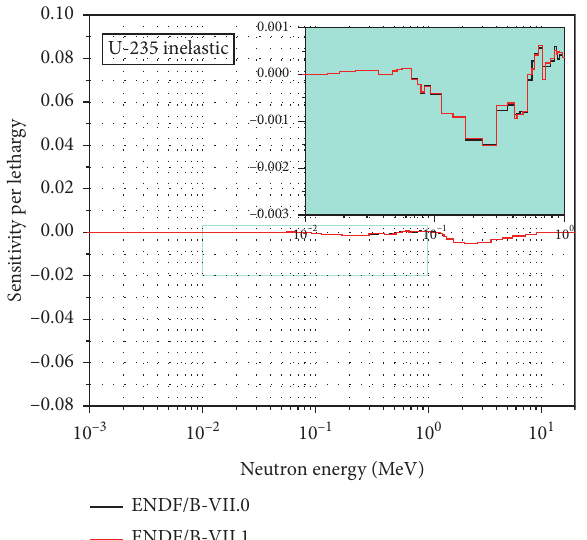
Figure 21: Energy-dependent sensitivities of k